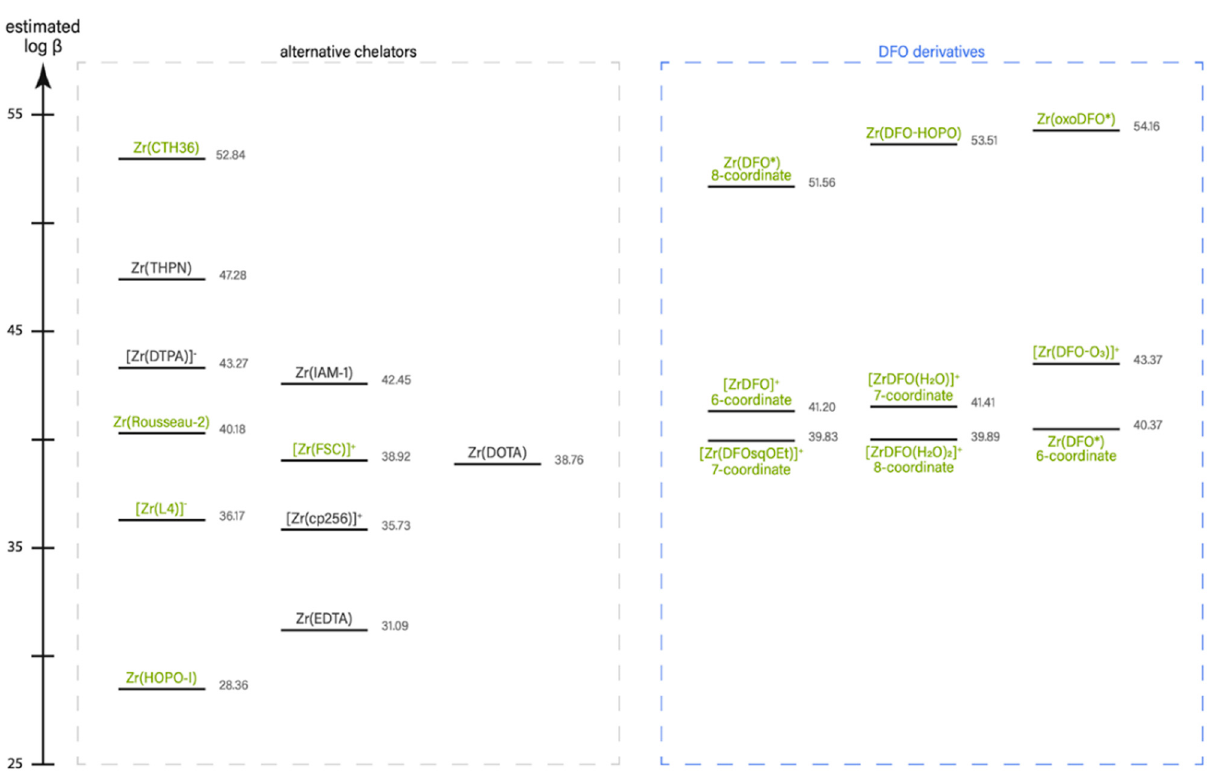
Figure 8. Plot of estimated formation constants for different Zr 4+ complexes. Ligands derived from DFO are shown in the right panel, others are grouped in the left panel. Black font-color indicates non-hydroxamate chelators, green hydroxamate chelators. Figure adapted from